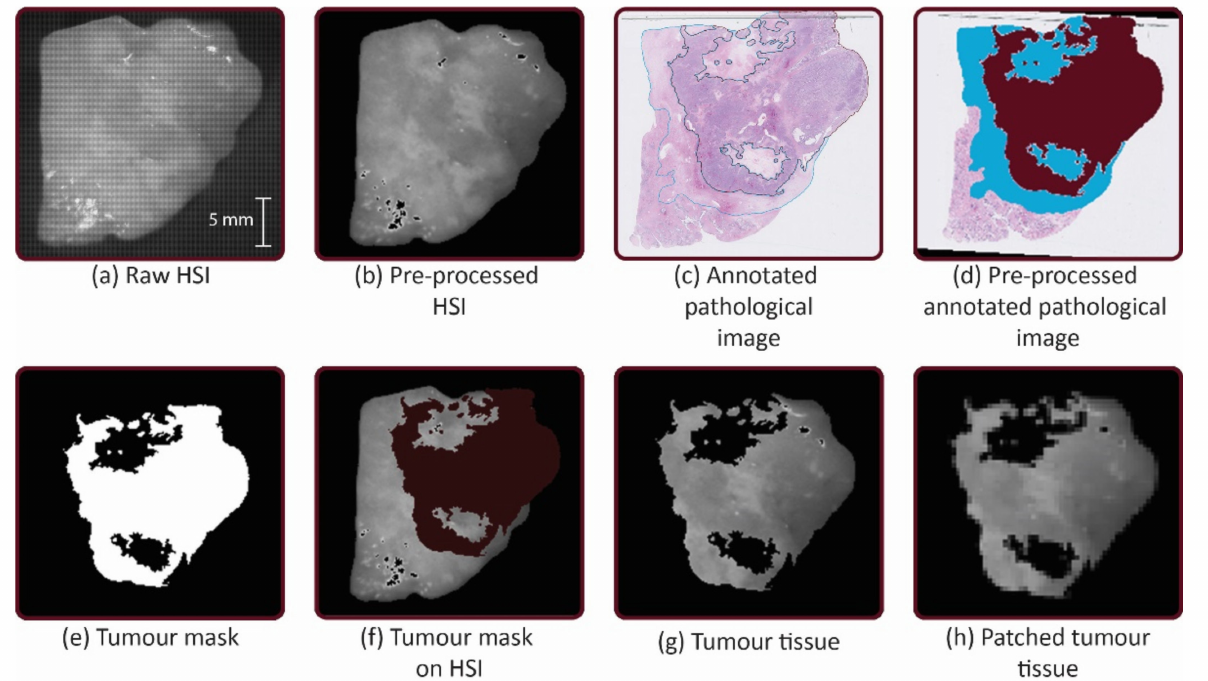
Figure 2. Workflow: ( a ) The hyperspectral (HS) images from the mosaic 5 × 5 hyperspectral camera were acquired after cytoreduction. ( b ) HS images were pre-processed by calibration, min-max nor- malization and noise filtering and transformed. ( c ) The digitized pathological images were annotated. ( d ) The annotated images were transformed. Tumor tissue was filled with the color bordeaux and the non-tumor tissue was filled with the color blue. ( e ) Tumor tissue and non-tumor tissue were selected via hue, saturation and value (HSV) color thresholding to make masks. ( f ) Selection of the tumor tissue and non-tumor tissue was made with the mask. ( g ) The HS images were multiplied by the mask to obtain tumor tissue and non-tumor tissue. ( h ) The HS images were patched into a grid of 20 × 20 pixels and features were